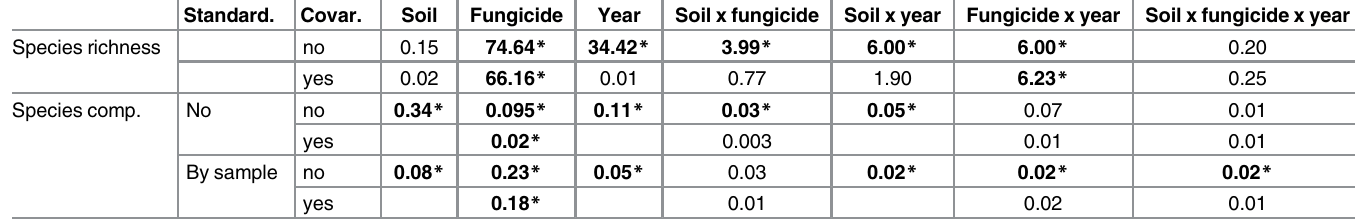
Table 1. The effects of soil type, fungicide and their interaction on plant species richness and plant species composition in the experiment. F- value for species richness and proportion of variance explained for species composition are shown. Significant values (p (cid:2) 0.05) are in bold and marked by * . Covar. indicates that abiotic characteristics of the soil were used as covariate. Df Error = 48. A full table including p-values is given in S2 Table. Standard.